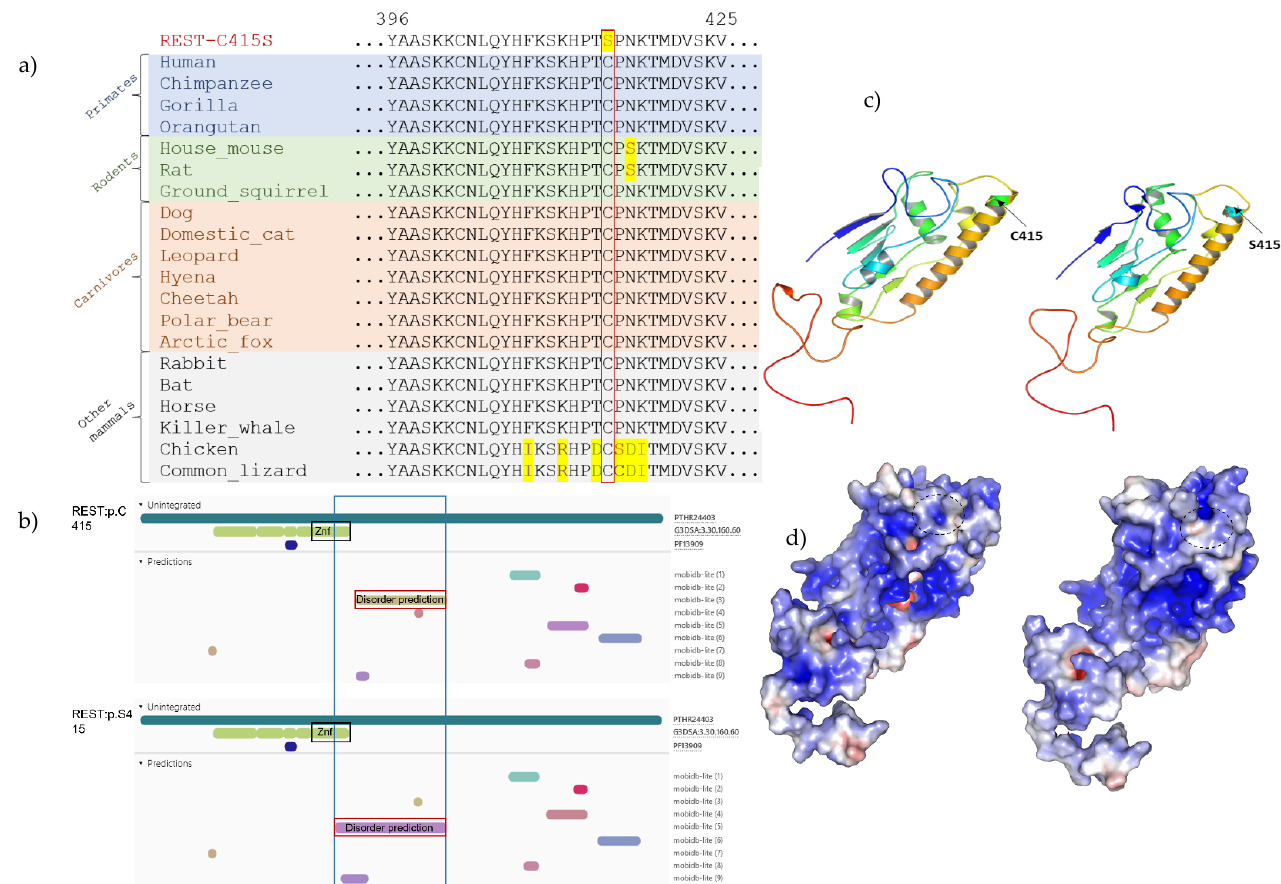
Figure 2. ( a ) The evolutionary conservation of the Cysteine amino acid at position 415 in REST. The position is indicated by the red box. ( b ) The domain structure of the WT and MT protein are shown. The mutant protein has an extended disordered domain when compared to the WT. ( c ) Protein modelling of REST comparing the WT (right) to the MT (left) in the ribbon form. The mutation results in changes in the β sheets and α helixes in the protein. This results in either the extension or the retraction of some the structures, as well as the formation and loss of other structures. ( d ) Protein modelling of REST comparing the WT (right) and the MT (left) in the space filling form indicating the consequences of the changes illustrated in (2c). The p.C415S variation results in a change in the tertiary structure of the protein such that it is slightly smaller than the WT protein. The MT protein also has several, previously exposed moieties, hidden.